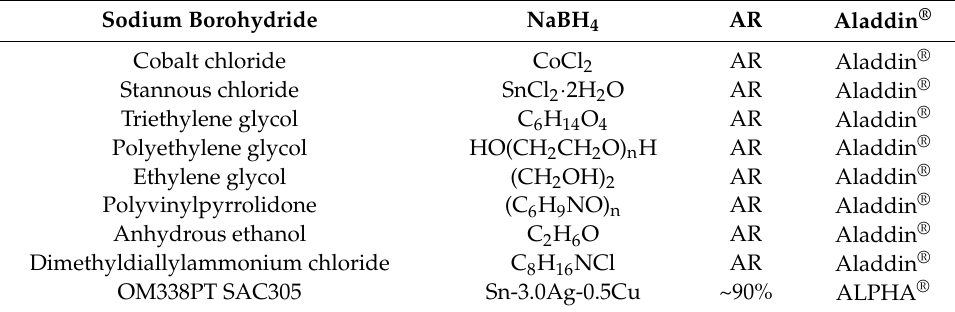
Table 1. Required raw materials and chemical reagents.